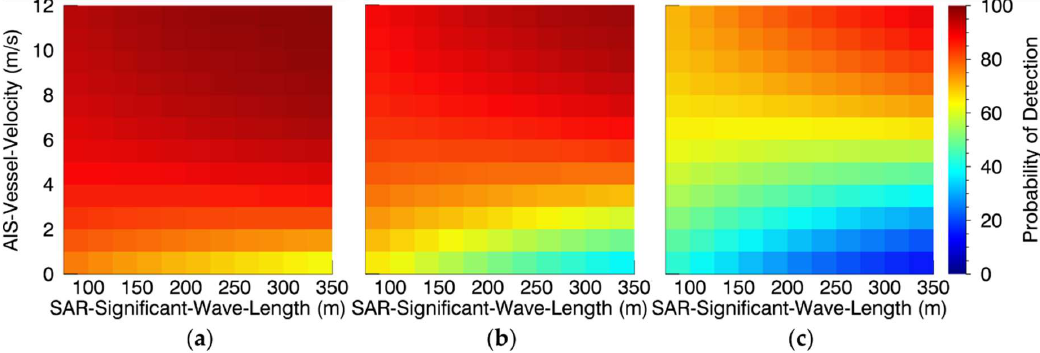
Figure 9. 2D detectability charts based on SAR-Significant-Wave-Length, AIS-Vessel-Velocity and from left to right Beaufort numbers with: ( a ) 1 bft, ( b ) 3 bft, and ( c ) 5 bft.